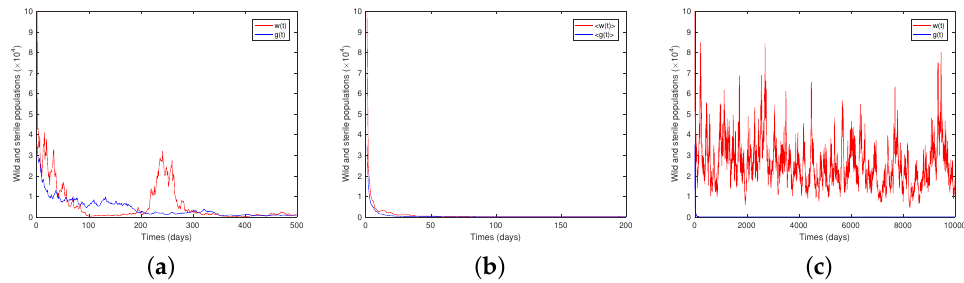
Figure 1. Solutions of Model (9) for µ 1 = ξ 1 = 0.5, µ 2 = ξ 2 = 0.4, a = 2, b = 0.5, w 0 = 10, step size ∆ t = 0.001. ( a ) is for σ